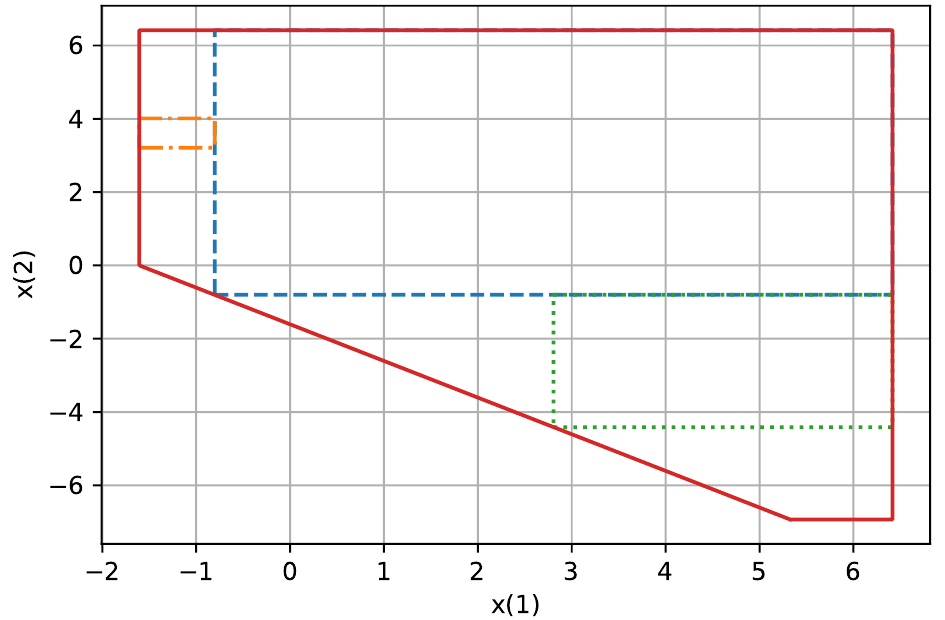
Figure 3. Inner approximation with cuboid homothets. Solid line: feasible region of the household; dashed line: stage zero solution; dashed-dotted and dotted lines: stage one